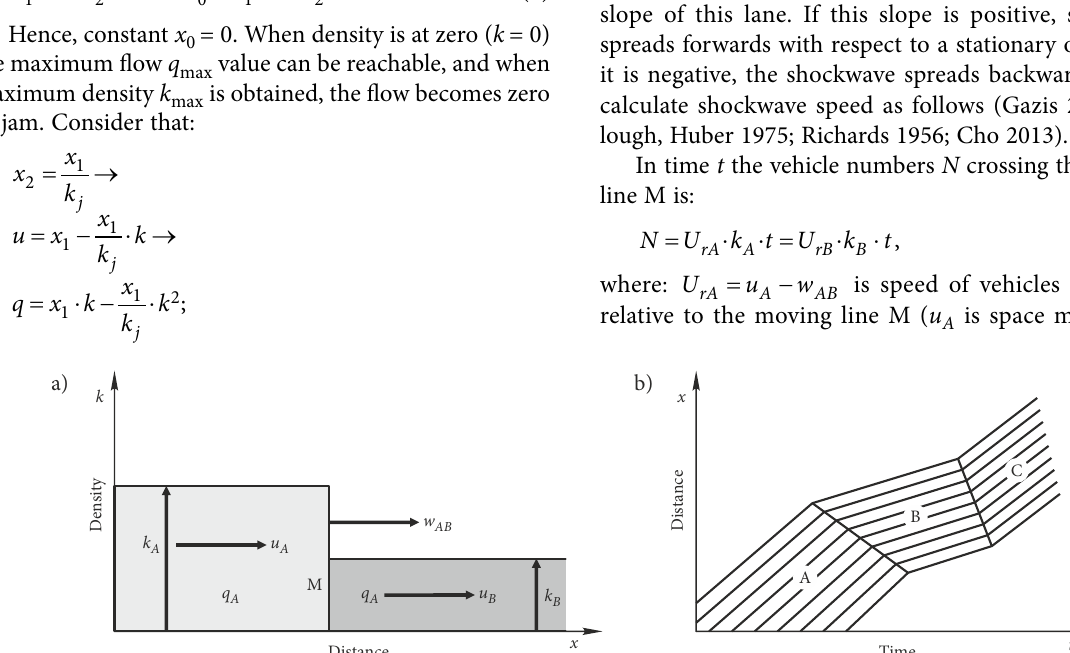
Figure 6. The movement (a) of different traffic densities and speed changes (b) of a moving platoon (Gazis 2002)